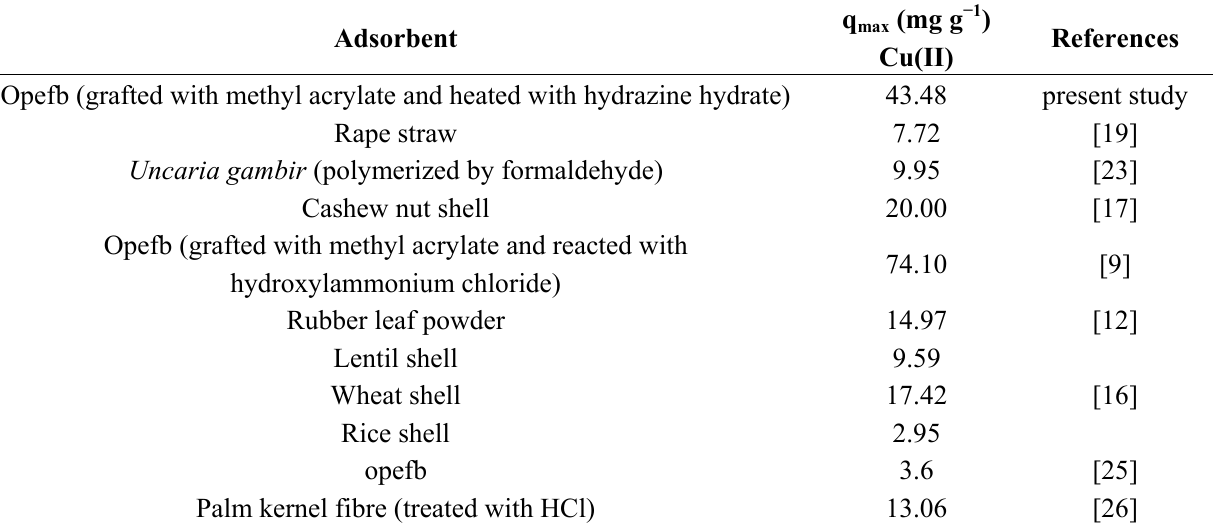
Table 2. Maximum adsorption capacities (Q